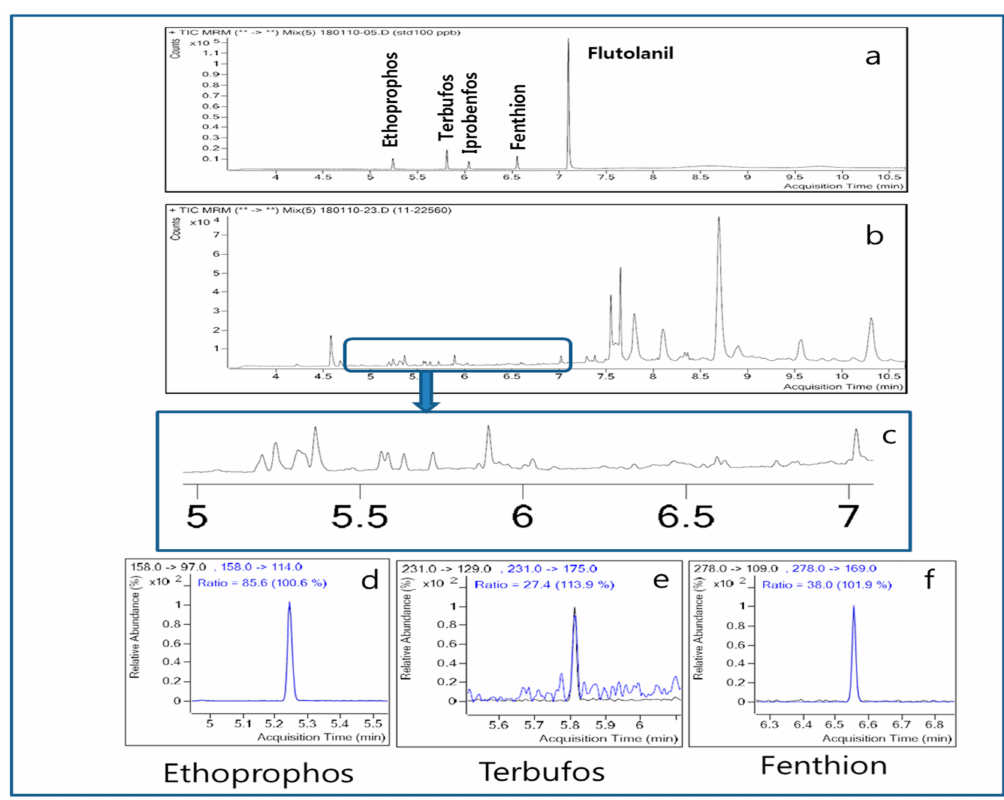
Figure 2. Identification of contaminating pesticides in the distillate obtained from the single-stage distillation. ( a ) Standards; ( b ) distillate; ( c ) enlarged region; ( d ) ethoprophos; ( e ) terbufos; ( f ) fenthion.